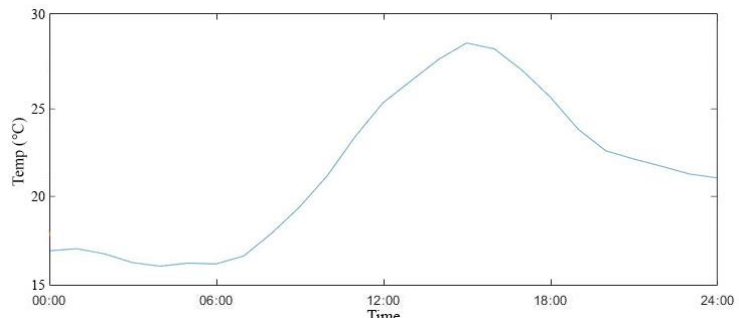
Figure 2. Outdoor temperature.